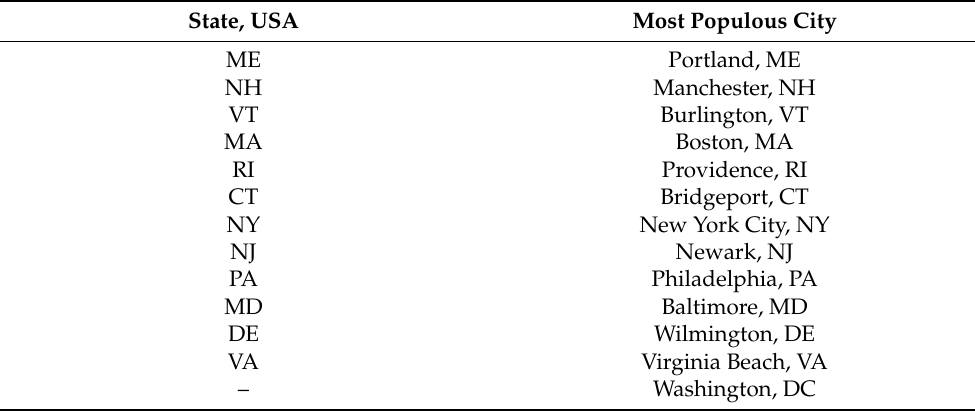
Table 1. The 12 states and 13 major cities in this study. For this study, the BosWash corridor was defined as 12 states from Maine to Virginia and each of the most populous cities in each state, and Washington, DC were included for